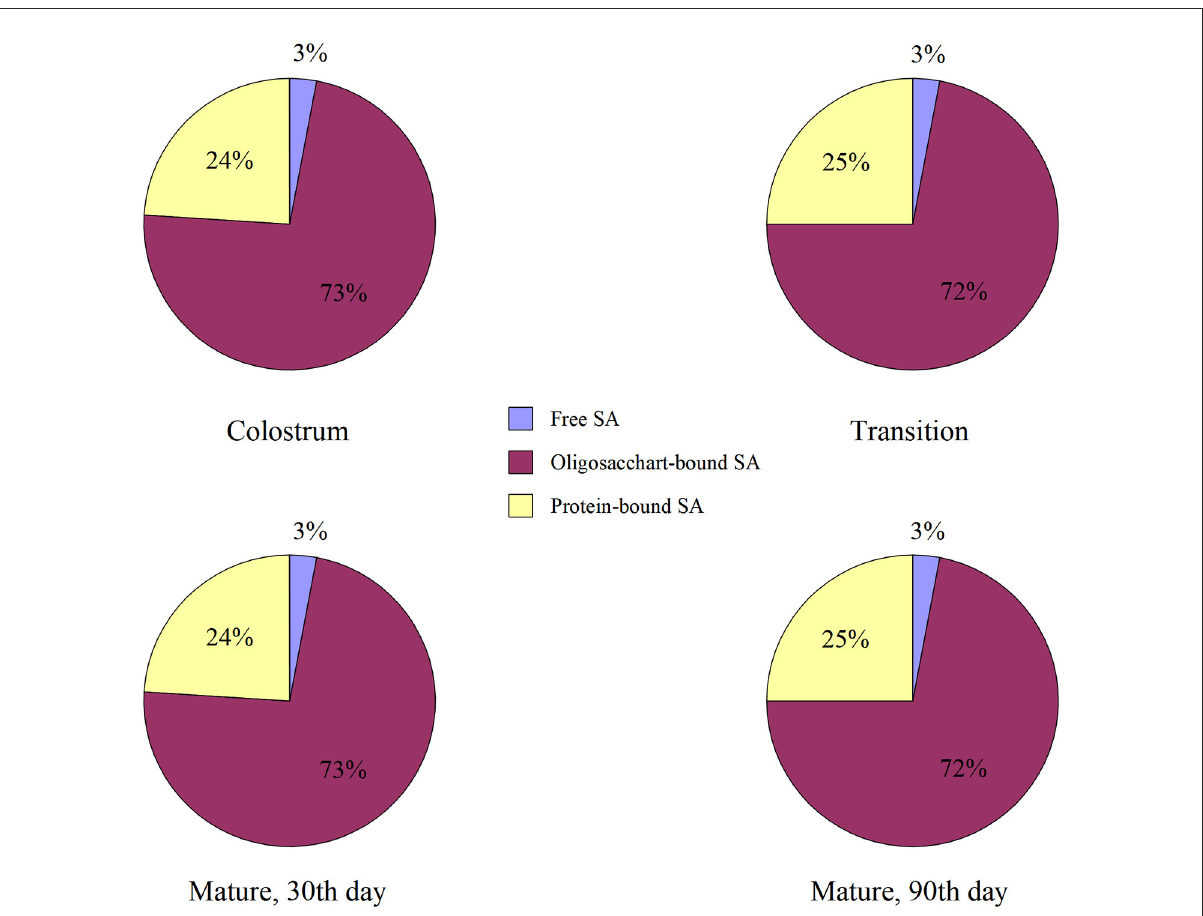
FIGURE1 Distribution of sialic acids in human milk in different lactation. The milk samples of 33 mothers were collected on the 3rd, 8th, 30th and 90th day during lactation to detect the content of sialic acid. The results showed the proportion of different forms of sialic acid at different time points. Colostrum, 3rd; Transition, 8th; The results are expressed as percentage (%); n = 33.